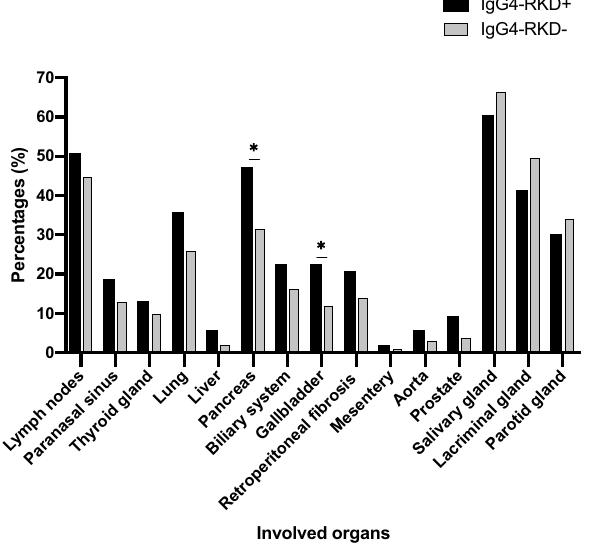
Figure 2. Summary of affected organs in IgG4-RKD+ and IgG4-RKD− patients at